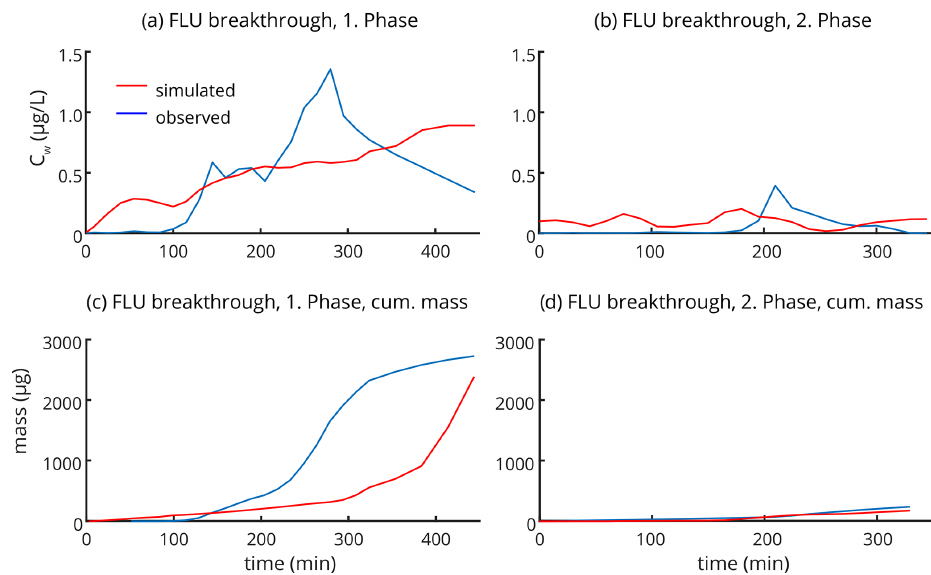
Figure 7. LAST-Model results of FLU breakthrough simulations with FLU concentrations C w in the tile-drain tube of the field site. (a) and (b) show FLU concentration changes over time and (c) and (d) present cumulated FLU masses in the two irrigation phases, respectively (cf. Sect. 4.1.4 and